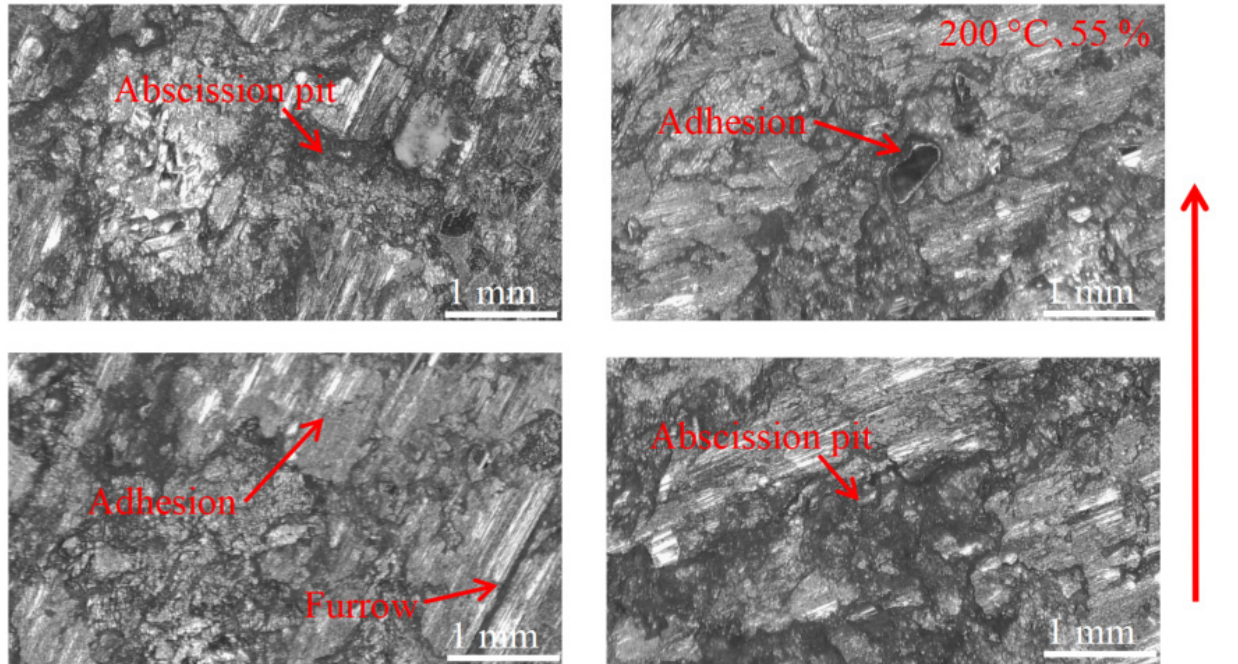
Figure 20. Surface morphology damage map of brake pad at 200 °C and 55% ambient humidity.